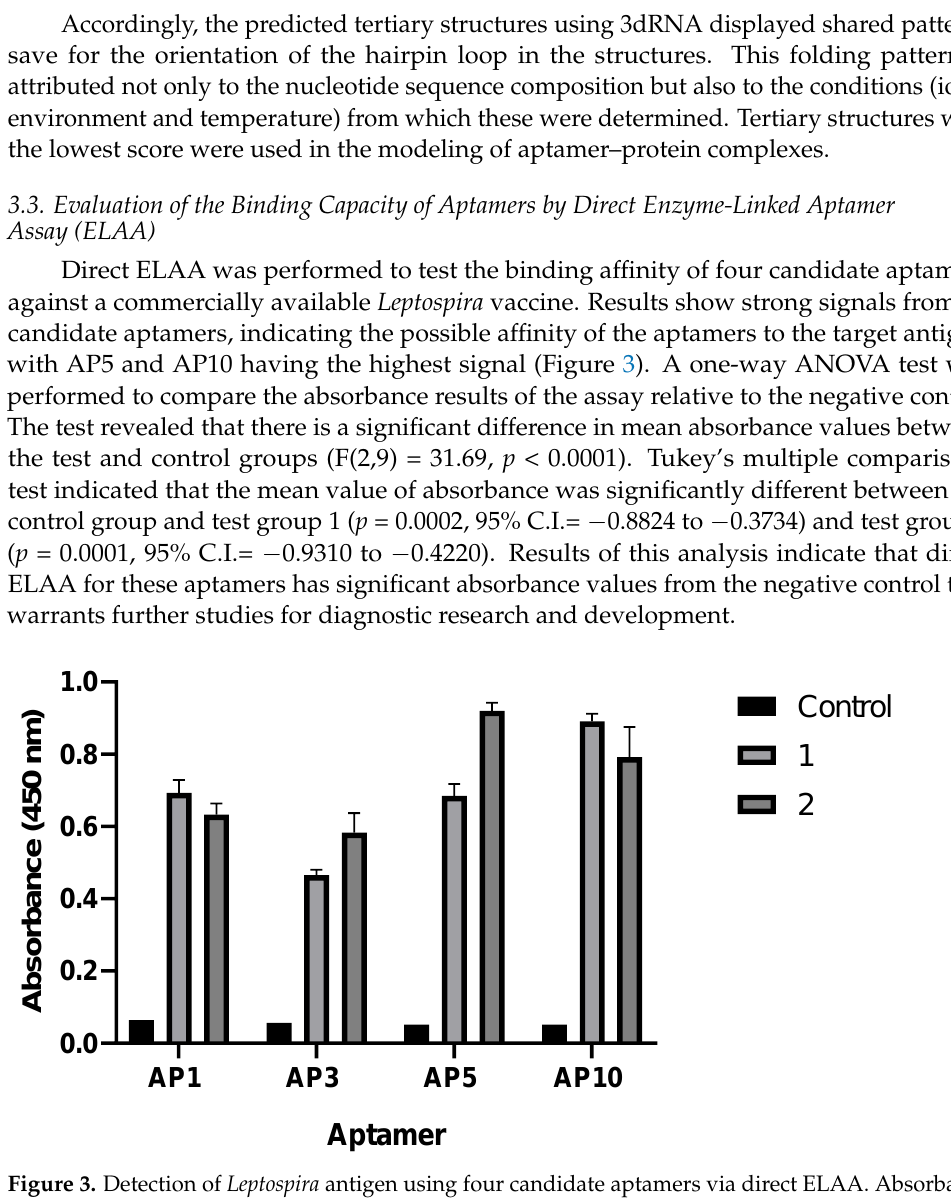
Figure 3. Detection of Leptospira antigen using four candidate aptamers via direct ELAA. Absorbance reading was at 450 nm. One-way ANOVA indicates a significant difference between control and test groups at p < 0.0001. Tukey’s post hoc multiple comparisons test: control vs. 1 ( p = 0.0002) and control vs. 2 ( p = 0.0001).